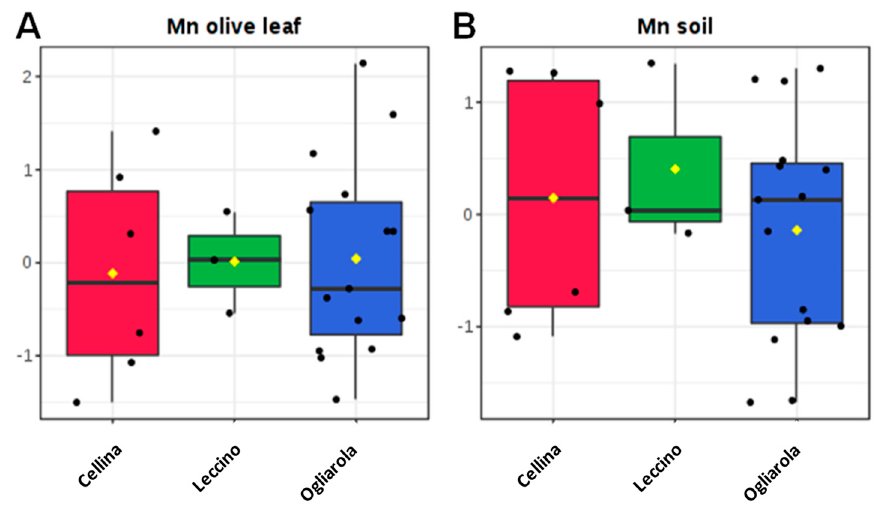
Figure 6. Box plots concentration for manganese olive leaf ( A ) and soil ( B ) samples of infected olive trees of Cellina di Nardò, Leccino and Ogliarola salentina cultivars, located in Taranto province (see also Table 1).